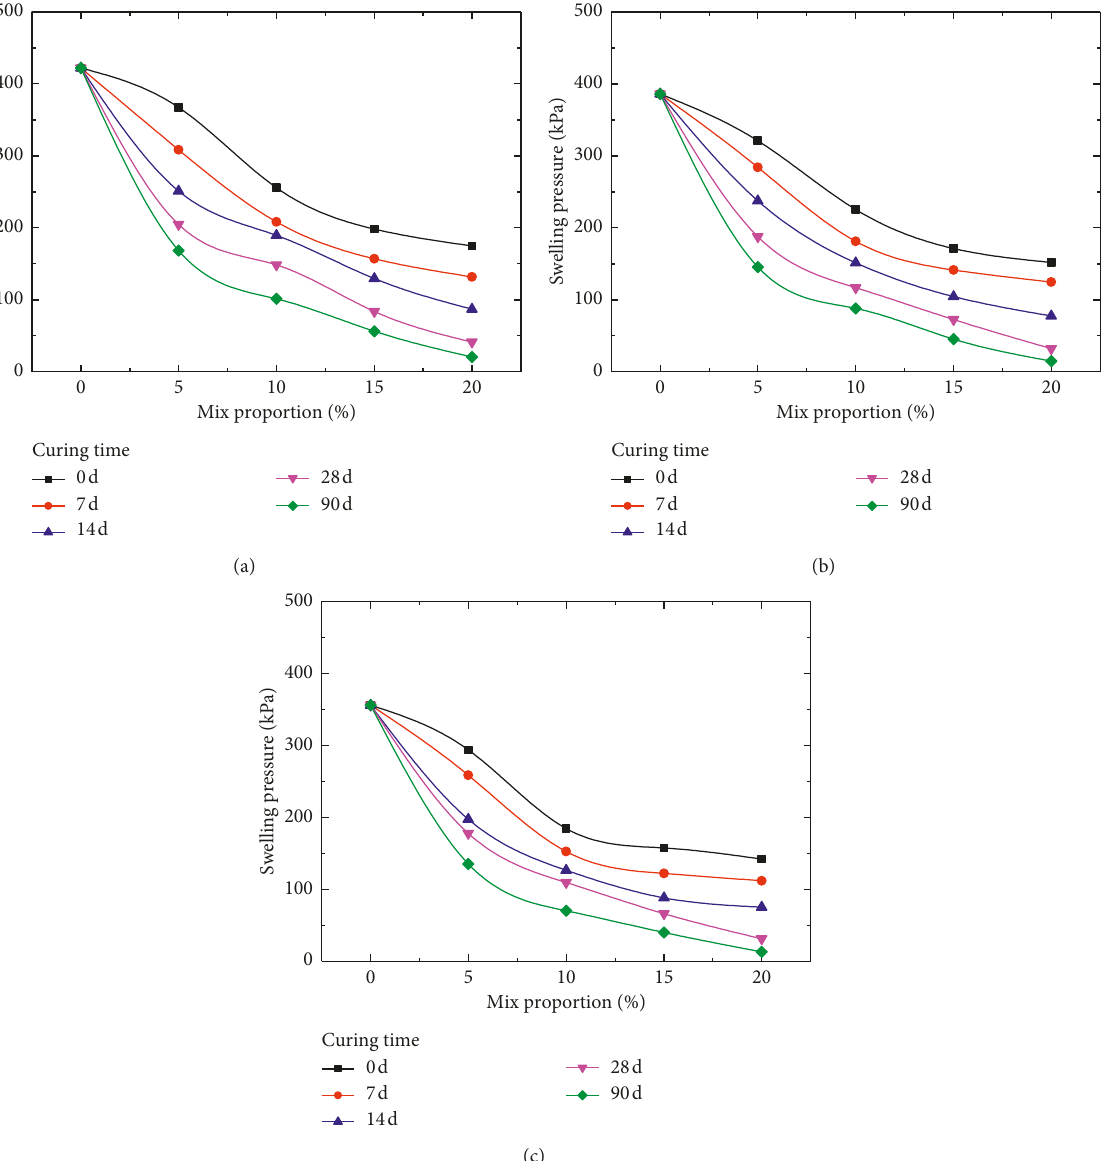
Figure 14: Swelling pressure of expansive soil stabilized by RHA-lime. (a) w